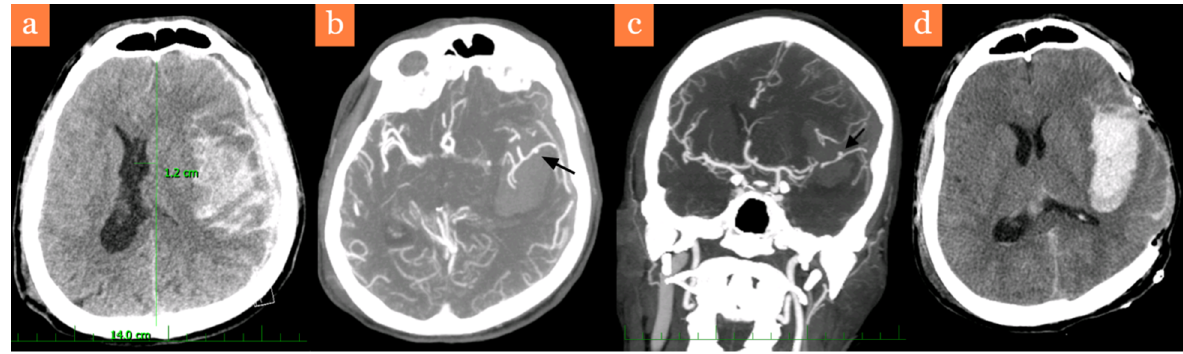
Figure 1. Graphic depiction of the case before the second surgery. ( a ) CT performed immediately after admission, showing a severe midline shift of 12 mm, ( b , c ) axial and coronal CT angiography (CTA) views depicting a large intracerebral hematoma in the sylvian fissure and a broad base M3 aneurysm, ( d ) postoperative CT after decompressive craniectomy (DC), without complications with midline shift regression and the intact intracerebral hematoma.